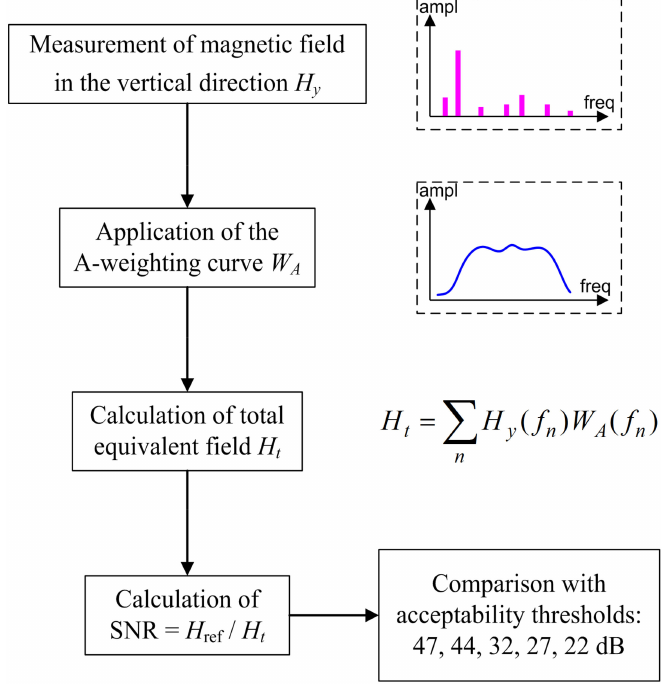
Figure 9. Procedure for measurement and quantification of interference to hearing aid system (AFILS) through SNR